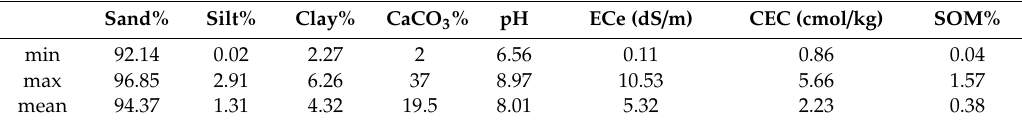
Table 1. Basic statistics of chemical analysis of the study